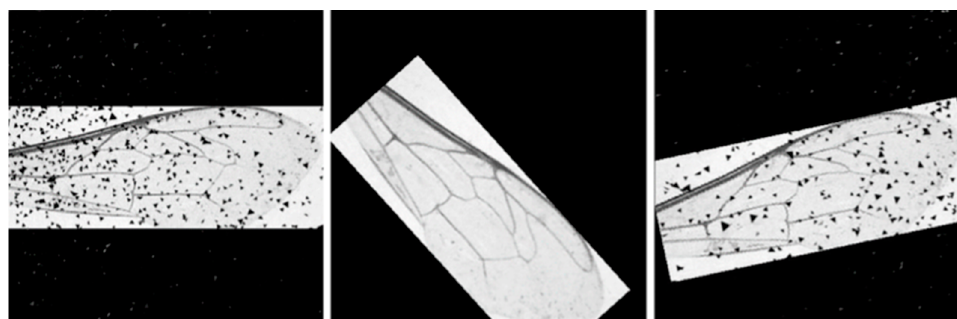
Figure 4. Examples of U-Net output masks.